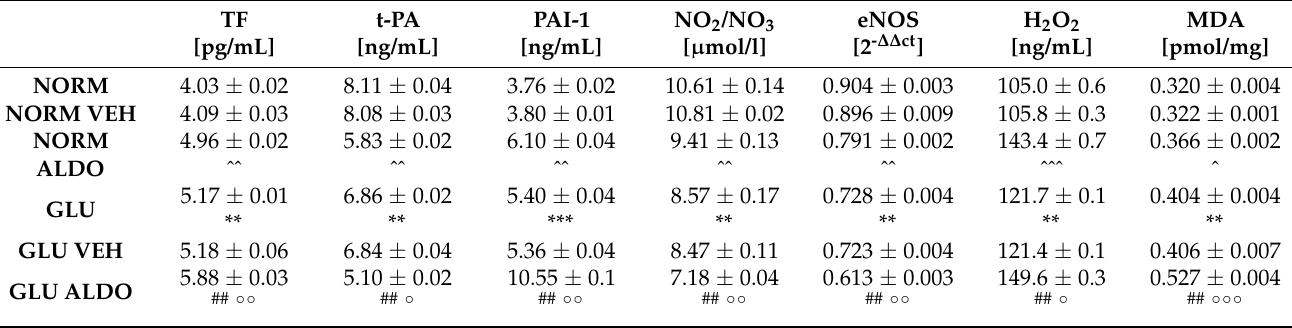
Table 3. The effect of aldosterone on hemostasis, nitric oxide bioavailability, and oxidative stress parameters in the human umbilical vein endothelial cells under normoglycemic and hyperglycemic